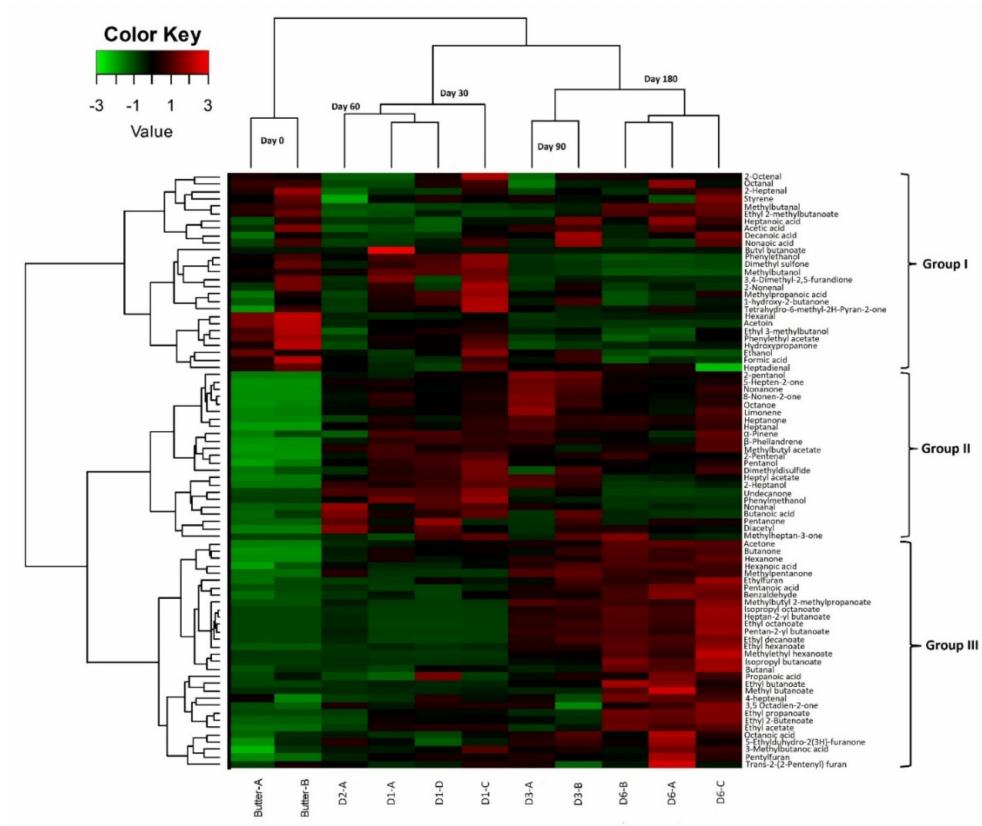
Figure 8. Normalized heat-map representation of volatile abundances during Smen maturation. Hierarchical clustering was performed using Ward’s Linkage and Euclidean distance. (D1, D2, D3, D6: Smen after one, two, three, and six months of maturation,